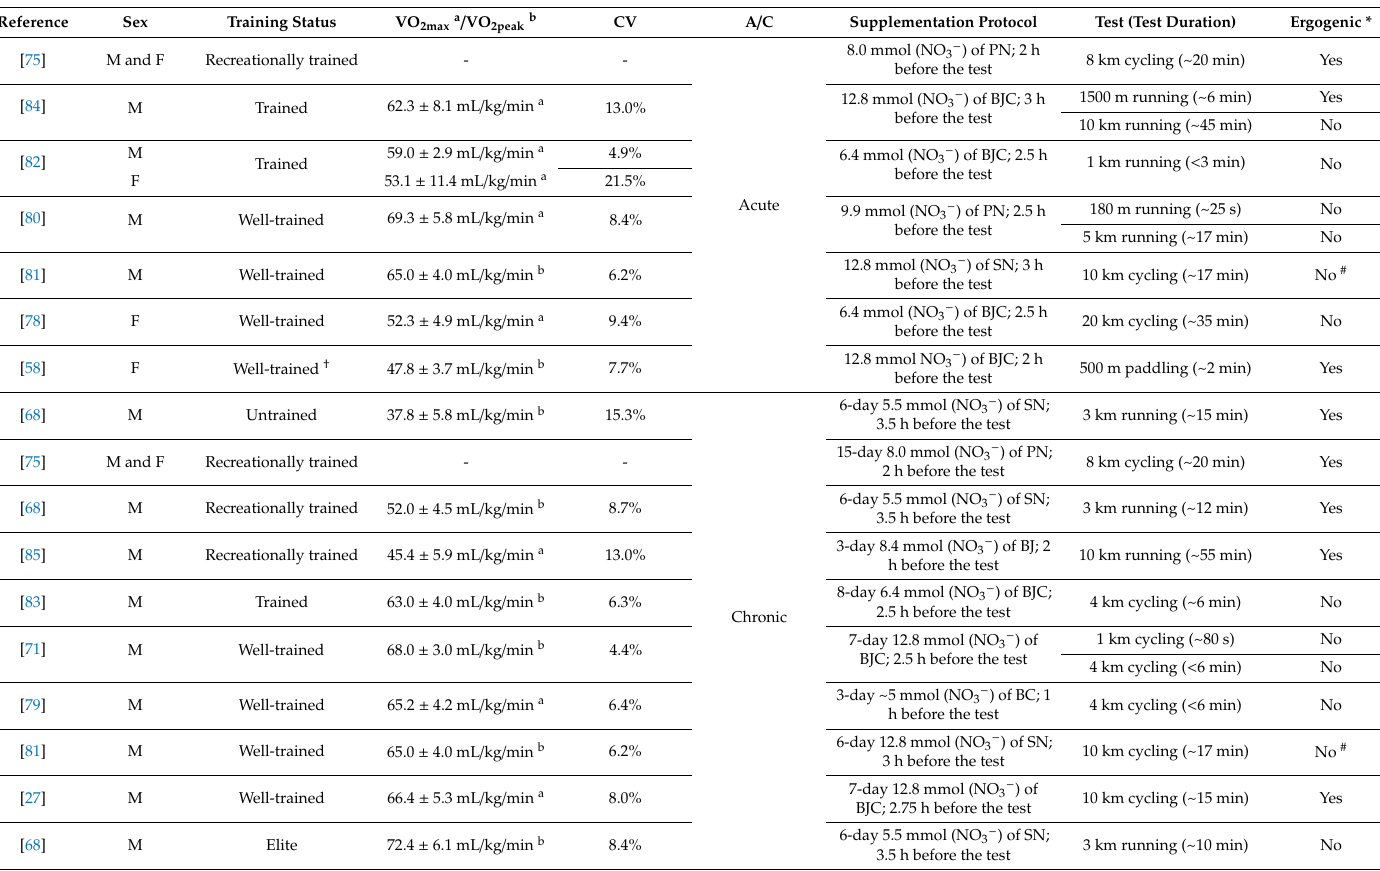
Table 2. Relationship between DN supplementation protocol and training status in promoting the ergogenic e ff